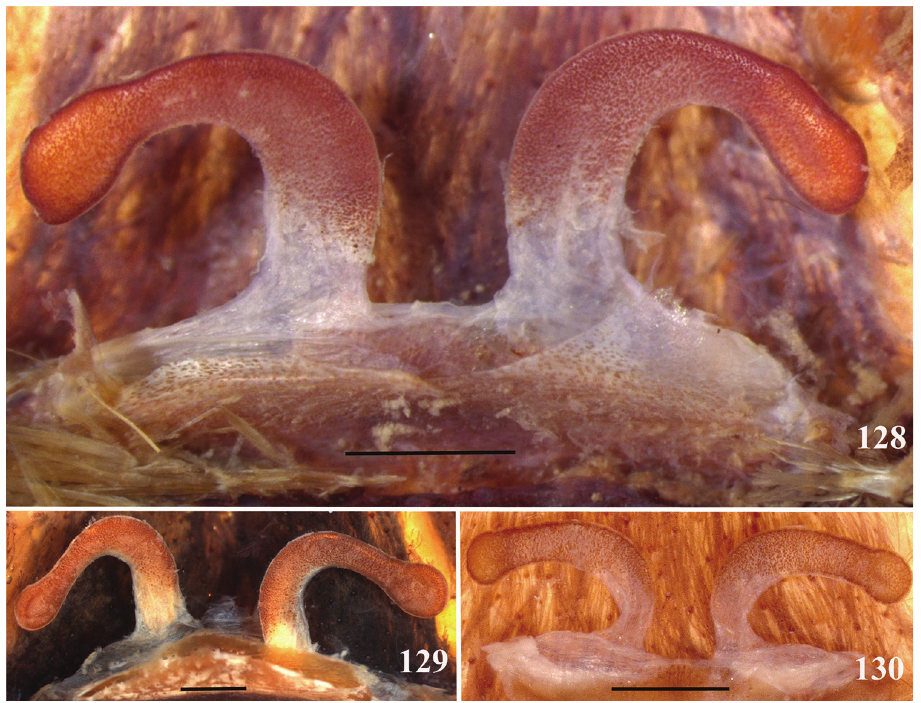
de São Domingos and Pontes & Lacerda, state of Mato Grosso, Brazil (IBSP 10264) 129 Rio Negro, state of Amazonas, Brazil (AMNH RW29) 130 Tomé-Assu, state of Pará, Brazil (IBSP 3105). Scale bars = 1